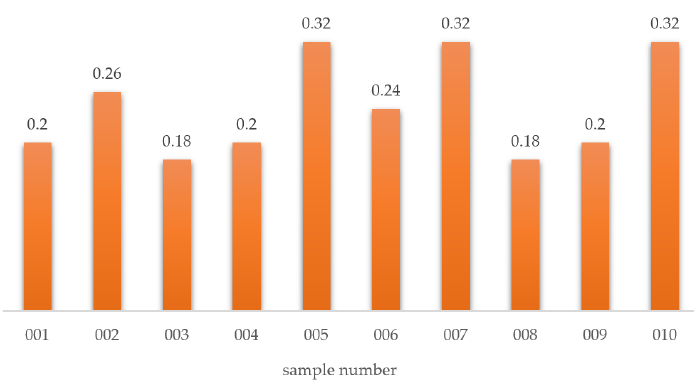
Figure 12. Flexural load-bearing capacity of the selected tiles.